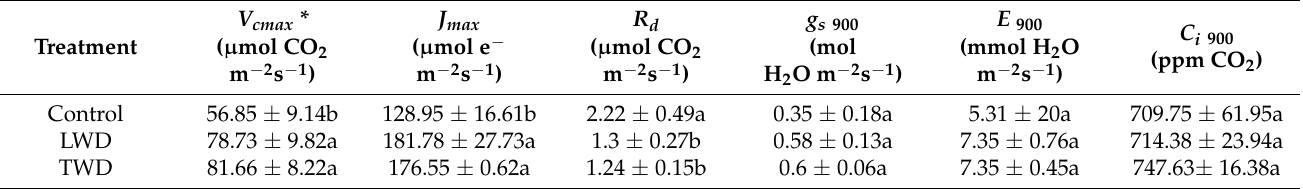
Table 1. Effect of long and terminal water regimes (LWD and TWD) on the photosynthetic and gas exchange parameters of the flag leaf of wheat growing under combined elevated CO 2 and high temperature. Means of data are represented ± SD. Different letters next to values (a and b) indicate statistically significant differences among treatments after post-hoc test analyses ( p -value ≤ 0.05, n = 4, see Spreadsheet S1, Treatments). The number 900 stands for the value for the CO 2 concentration in ppm at which the photosynthetic parameters were